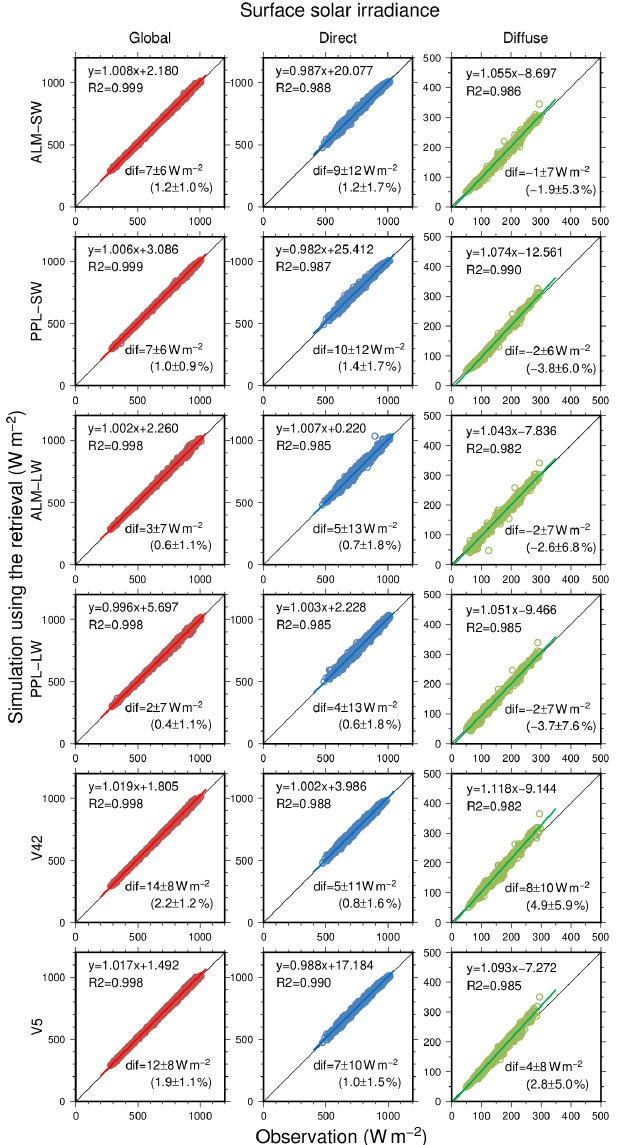
Figure 14. Comparison of global, direct, and diffuse solar irradi- ances between the measurements and the simulations using ALM- SW, ALM-LW, PPL-SW, PPL-LW, V42, and V5 retrieval results. The notation “dif” indicates the mean and standard deviation of the differences; y = ax + b and R2 are the linear fitting and coefficient of determination.